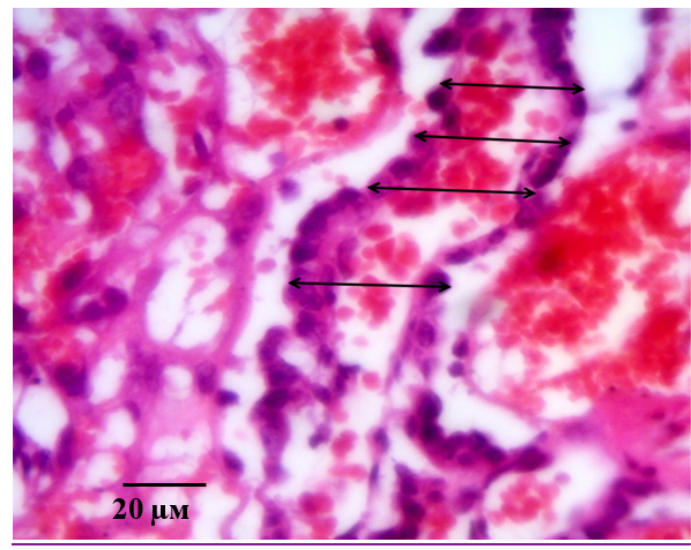
Figure 14. Measurement of the villi diameter (indicated by arrow) on the 21st day of gestation in animals with ADMA-like preeclampsia when pHBSP was administered at the dose of 250 µg/kg. Note: Hematoxylin and eosin staining. Magnification: 400×.